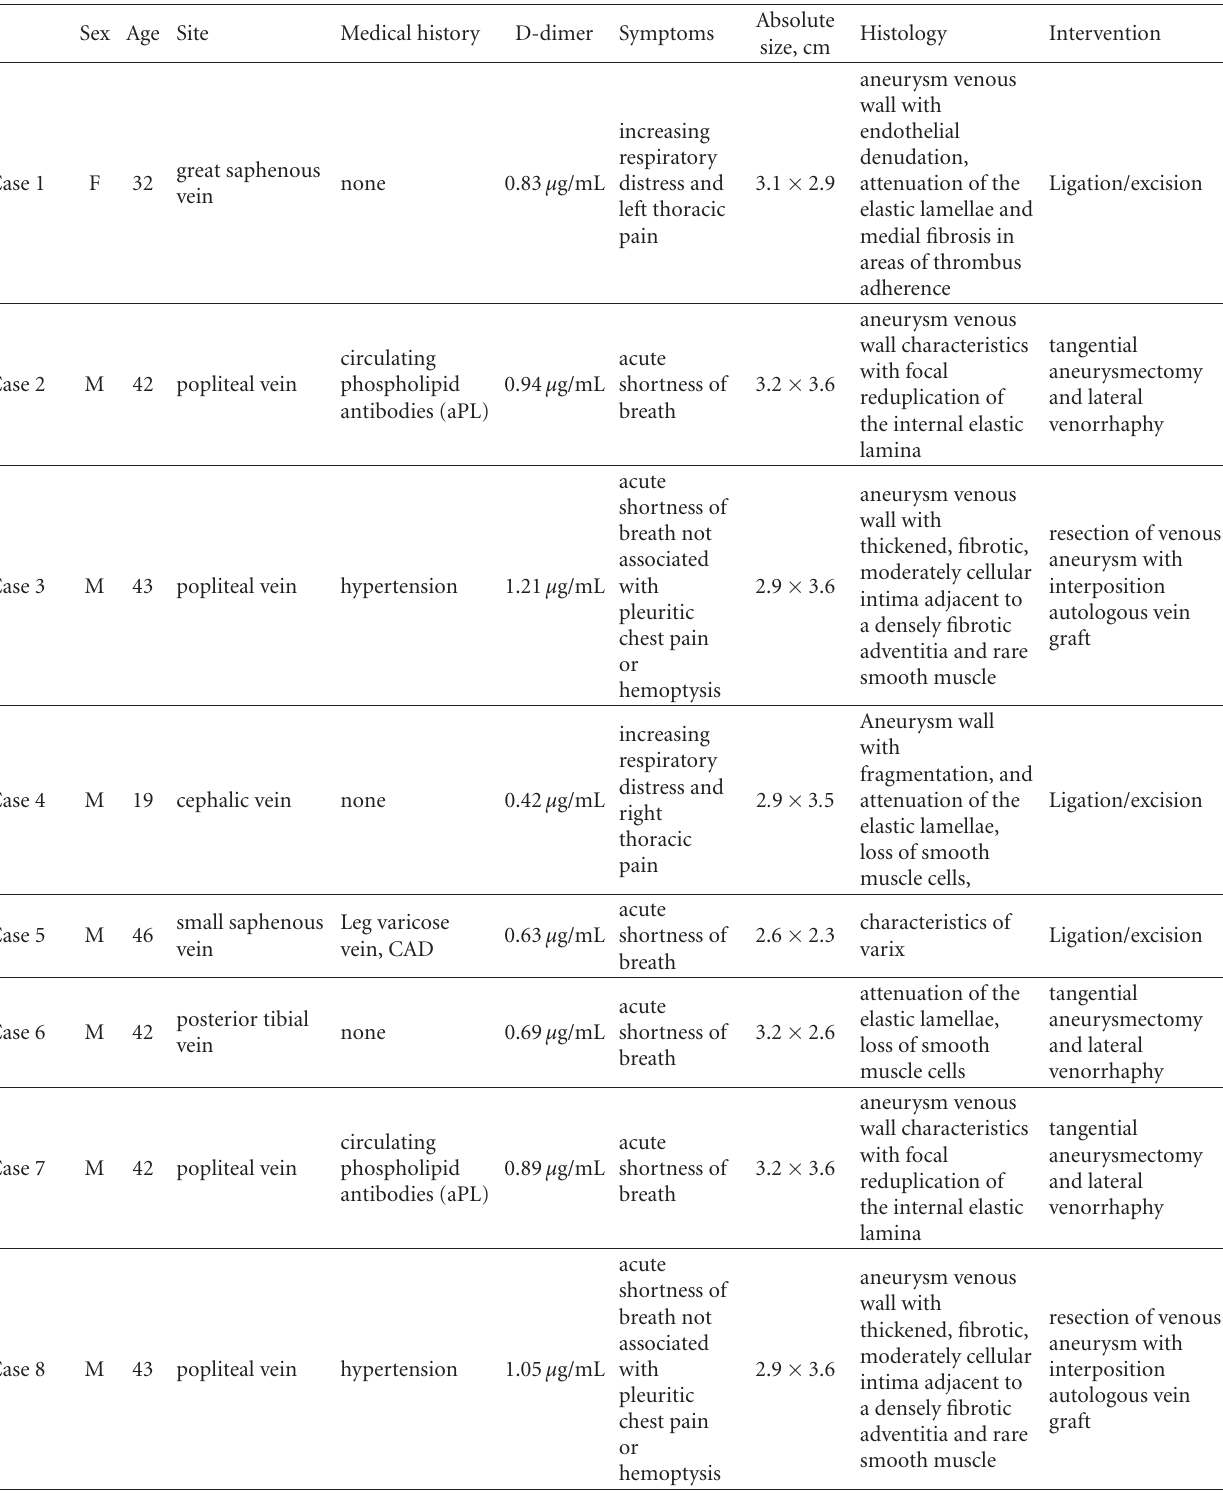
Table 1: Patient demographic and characteristic